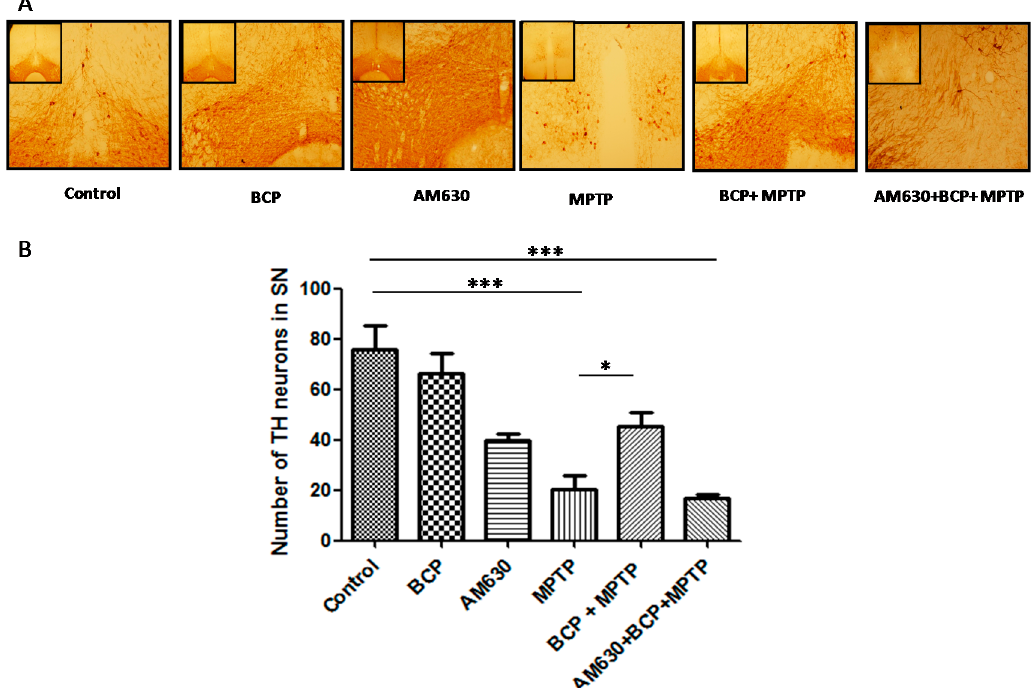
Figure 4. BCP treatment attenuates the MPTP-induced nigrostriatal dopaminergic neuronal